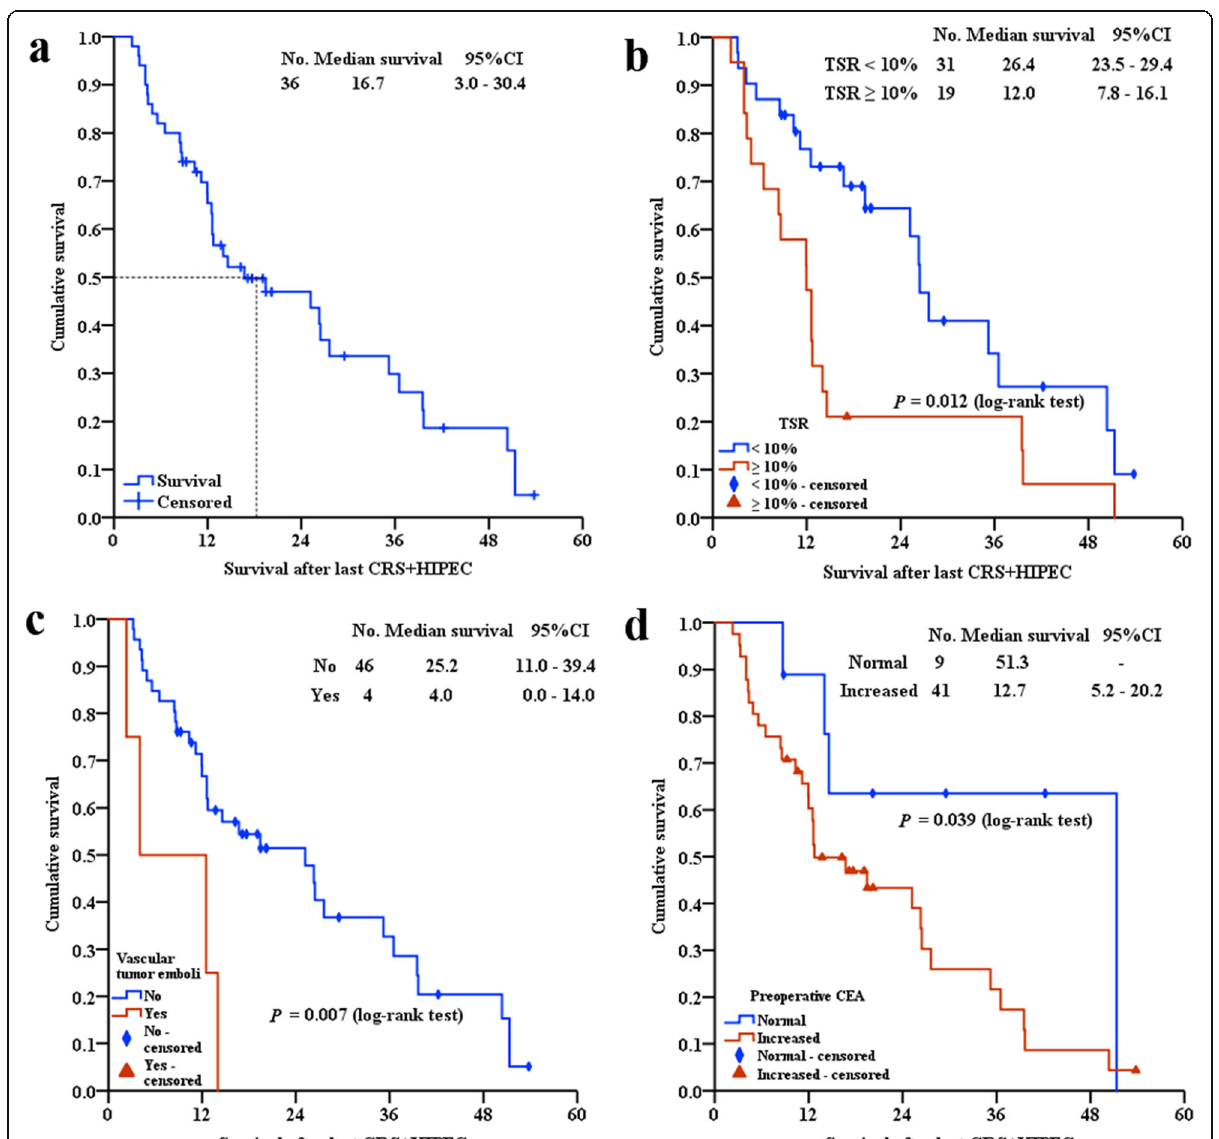
Fig. 3 Survival curve and univariate analysis of 50 PMP patients. A Survival curve; B TSR; C Vascular tumor emboli; D Preoperative CEA. PMP: Pseudomyxoma peritonei; TSR: Tumor-stroma ratio